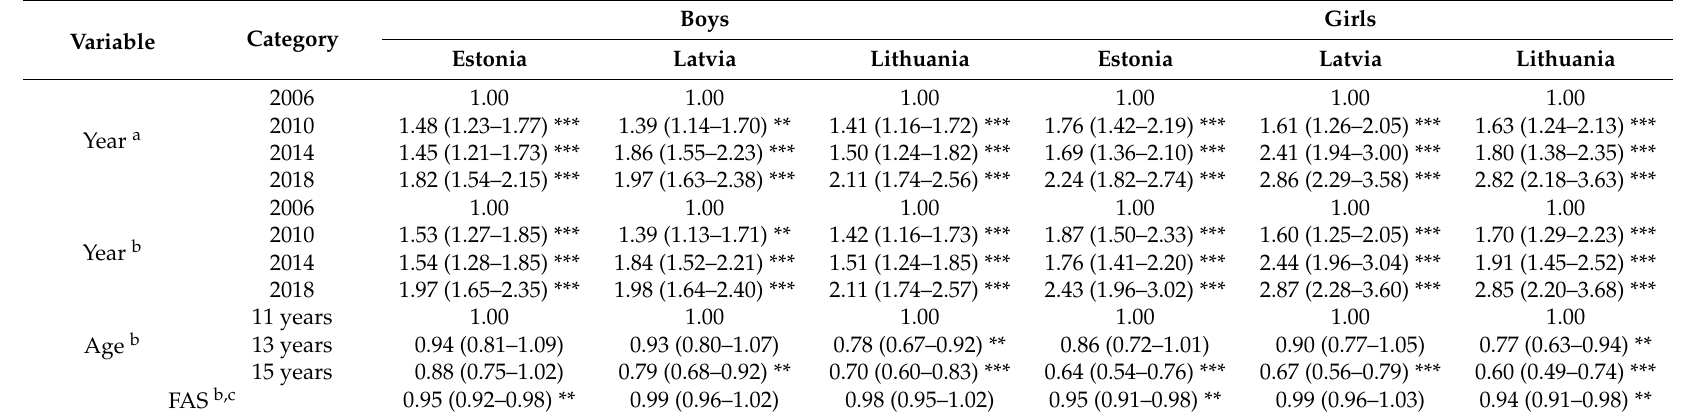
Table 6. Proportion of overweight / obese by survey year, age group and family a ffl uence (odds ratios and 95% confidence intervals).